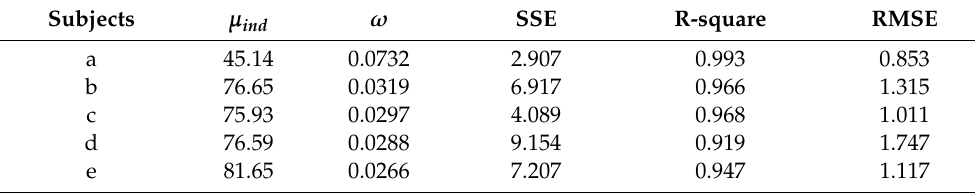
Figure 8. The comparison of different degrees of mental states. ( a ) Subject 1; ( b ) subject 2; ( c ) subject 3; ( d ) subject 4; and ( e ) subject 5. Table 8. The model parameter and goodness of fitness for 5